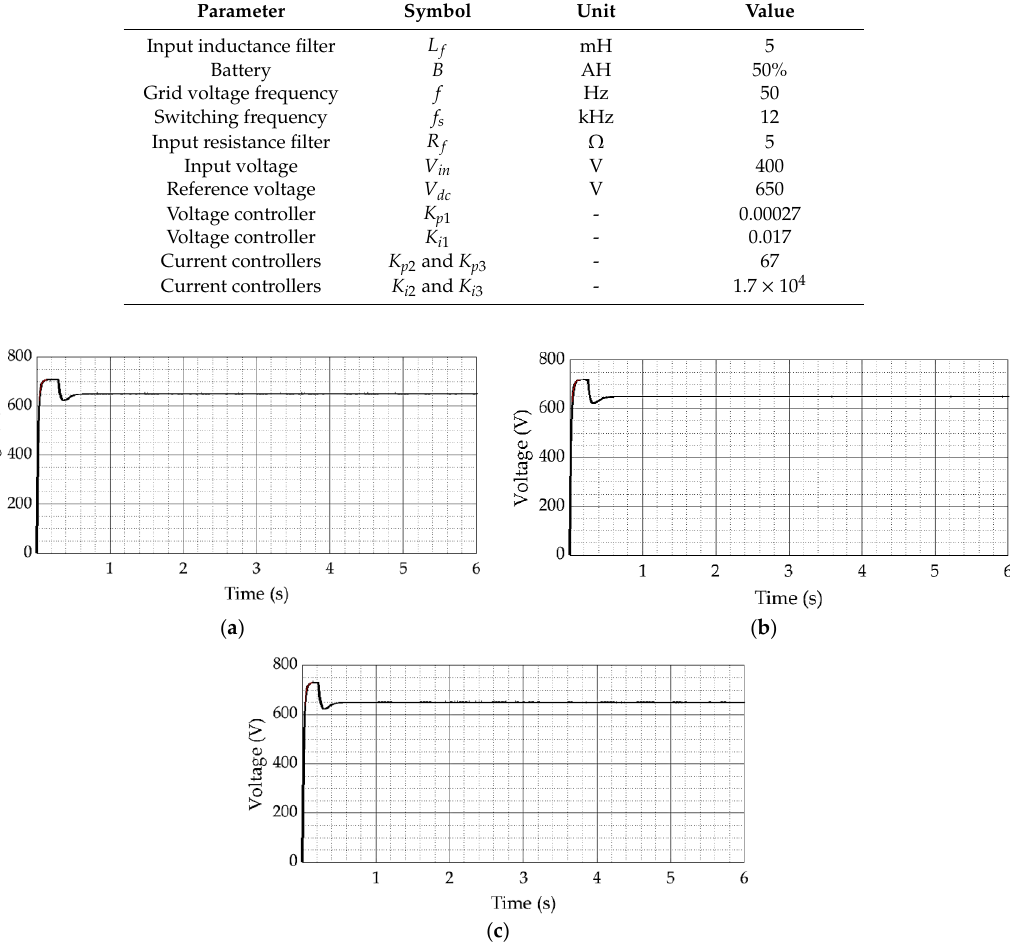
Figure 12. The output DC-link voltage of Level 3 charging for ( a ) nickel metal, ( b ) lithium ion, and ( c ) lead acid batteries. lead acid